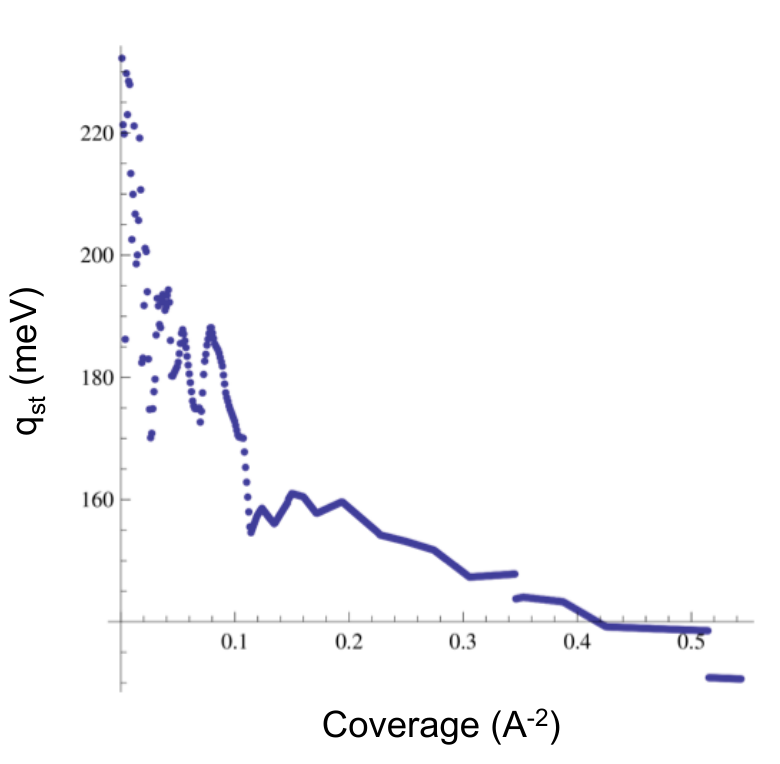
Figure 8. Isosteric heat of adsorption for CO 2